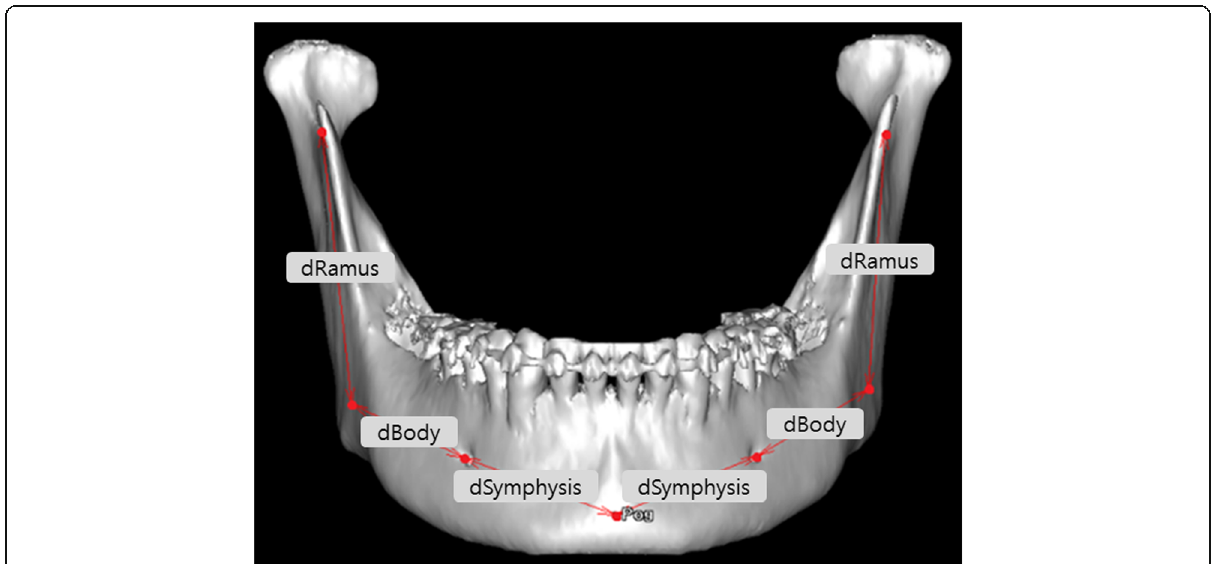
Fig. 1 Functional subunit of the mandible. dRamus, distance from the sigmoid notch to the gonion; dBody, distance from the gonion to the MF point; dSymphysis, distance from the MF point to the pogonion